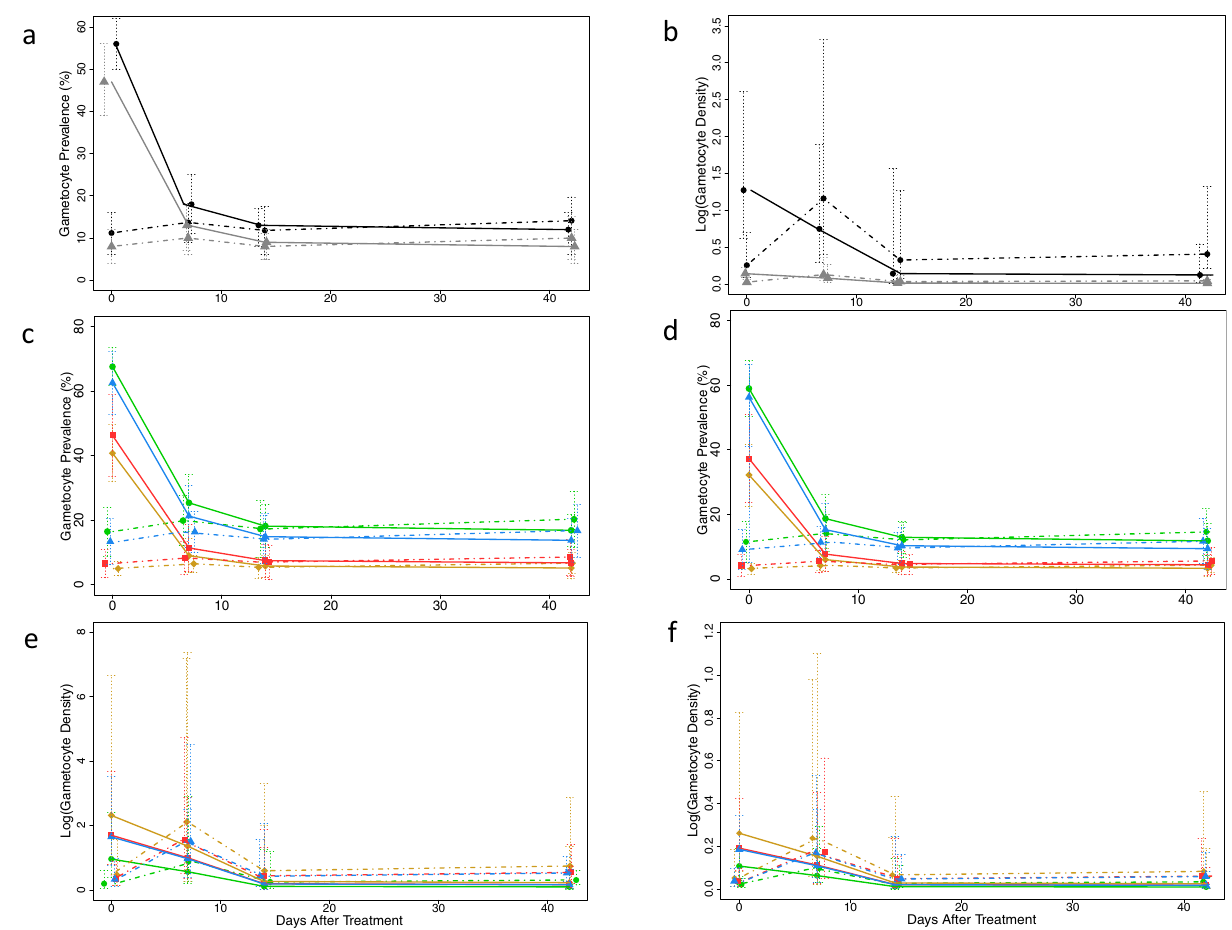
Figure 2. Impact of treating RDT positive students on the proportion and density of gametocytes in the school- based cohort over time. Proportion of students with gametocytes in all schools combined (a) and by school in the rainy (c) and the dry (d) season. Mean gametocyte density (logarithm transformed) among students in all schools (b) and by school in the rainy (e) and the dry (f) season. Solid lines represent students who received treatment; Dashed lines represent students who did not receive treatment. Color designates season in a and b rainy (black) and dry (gray). Color designates school in c-f Bvumbwe (yellow), Ngowe (red), Maseya (blue), Makhuwira (green). Both estimates were obtained in random effects longitudinal analysis (full models in Supplemental Tables S3 and